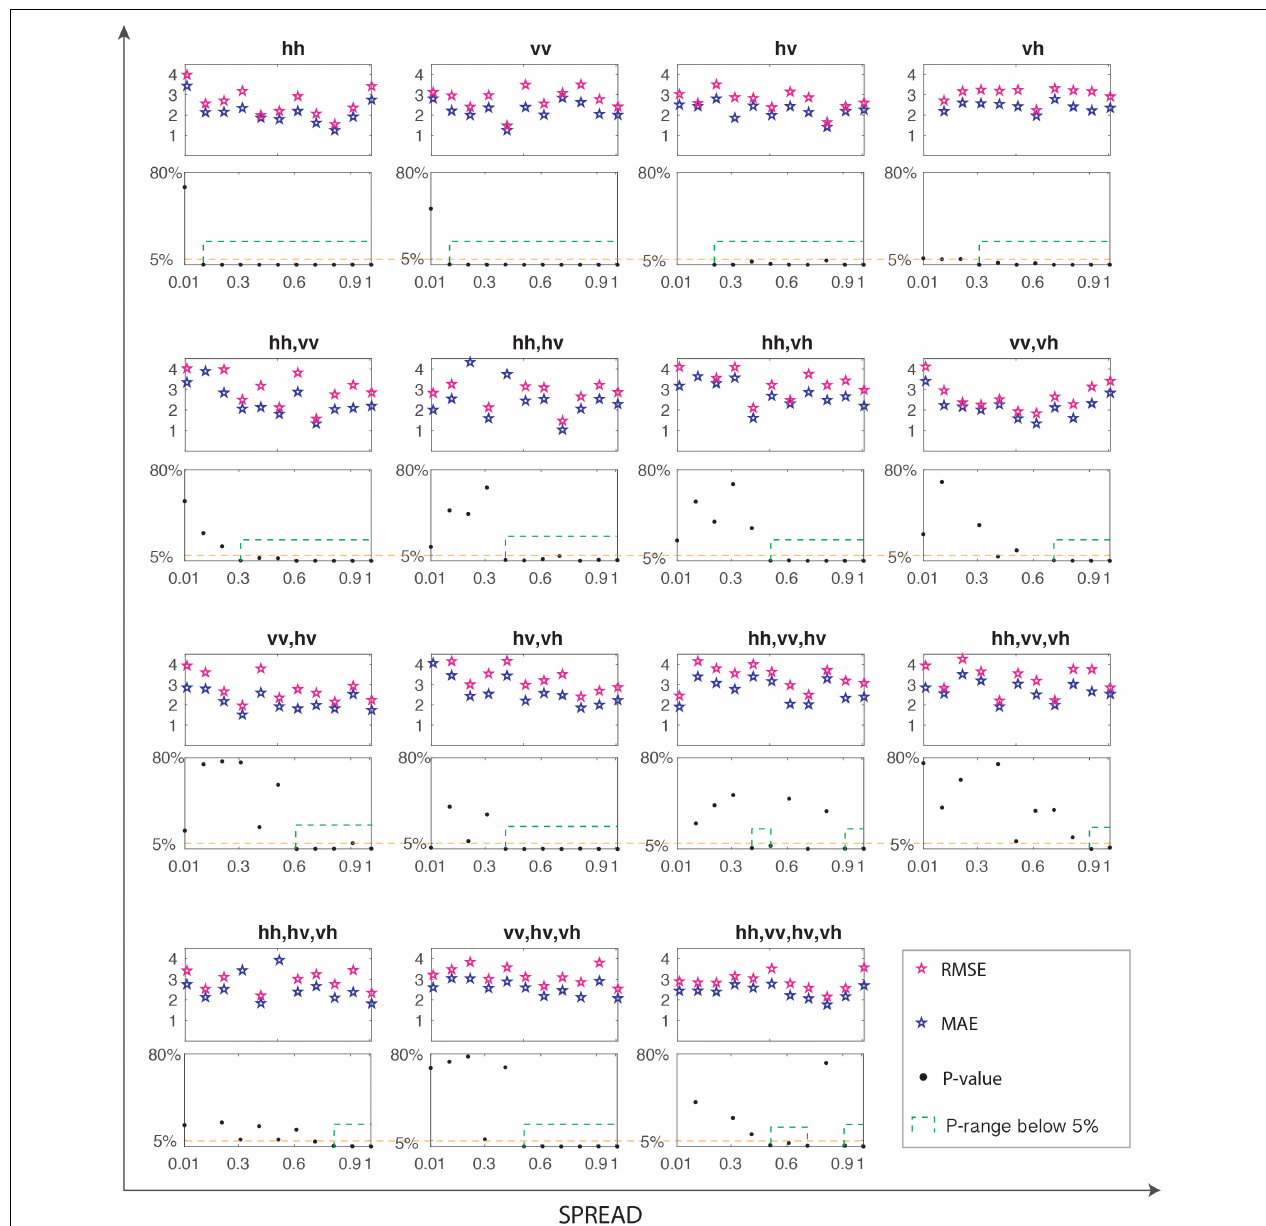
FIGURE 3 | The cross-validation results of 15 backscatter-BSSM models under the spread range from 0.01 to 1.